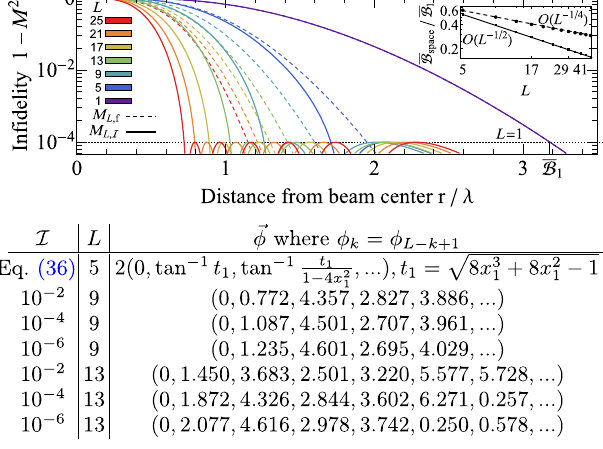
FIG. 3. Infidelity of spatially selective composite gates ð M f cos ½ð θ 0 = 2 Þ e − r 2 = 2 λ 2 (cid:2)g ; 0 ; · ; · Þ plotted for θ 0 ¼ π and L L; 10 − 4